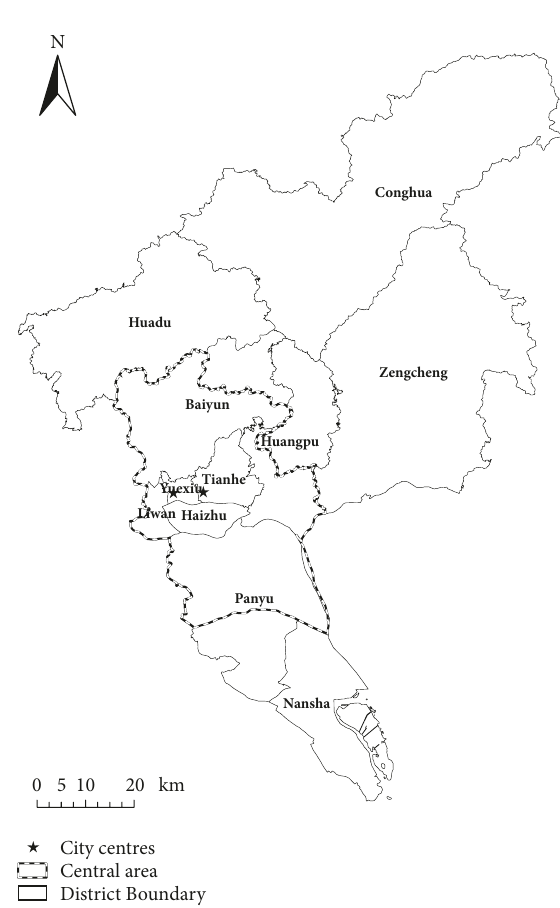
Figure 2: District Boundary of Guangzhou in